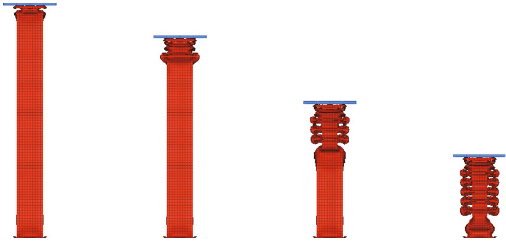
Figure 21: The deformation history of TRB